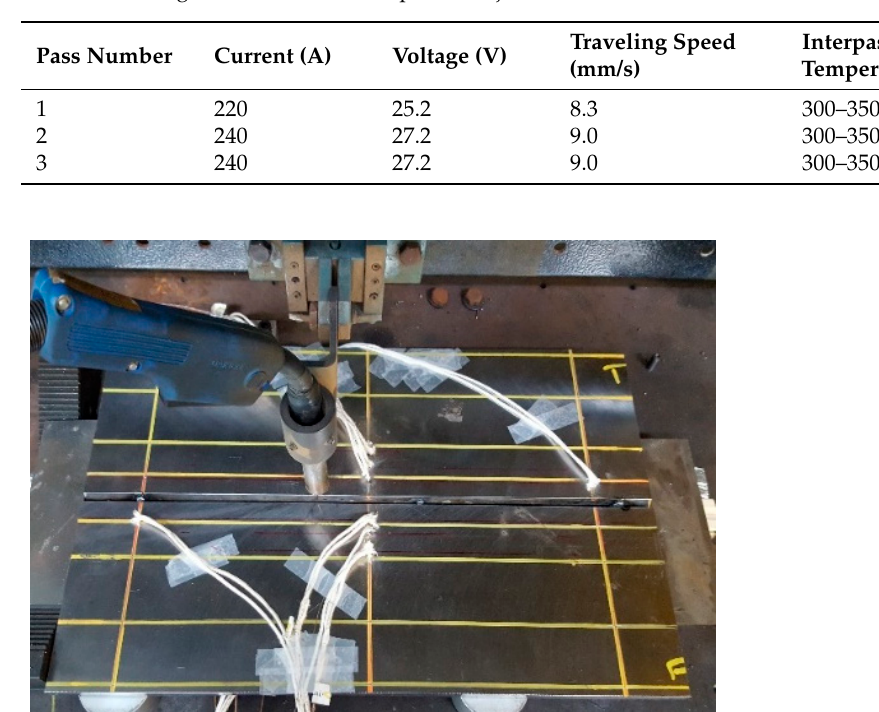
Figure 7. Specimen and equipment for butt-joint welding.